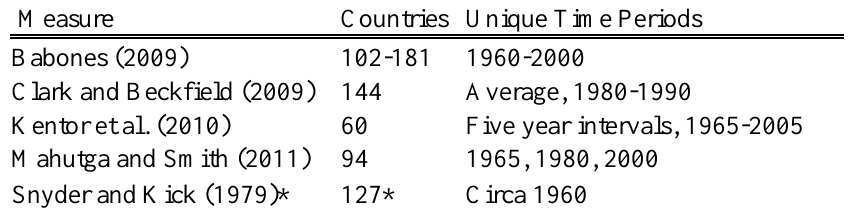
Table 1. Coverage of Five World-System Position